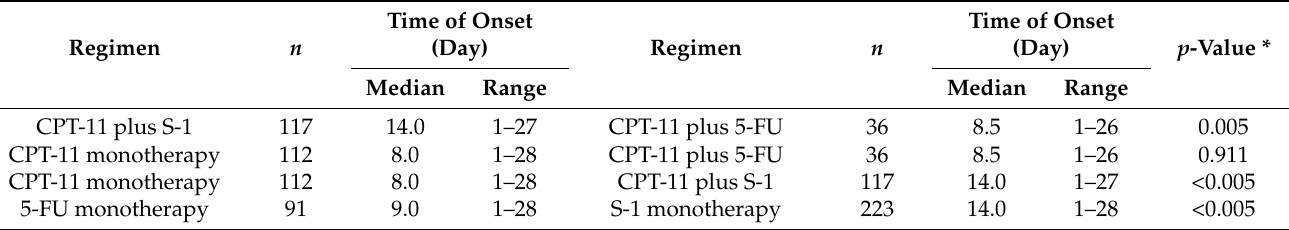
Table 5. Median onset of diarrhea induced by chemotherapy regimens.